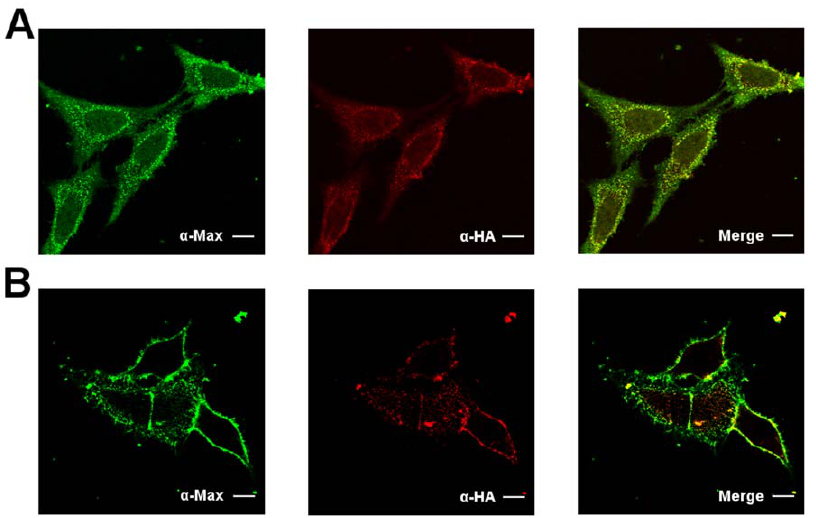
Figure 2. The b-HLH-LZ of Max directly transduces into HeLa cells. Confocal immunofluorescence photomicrographs of HeLa cells incubated for 20 minutes with Max*-HA at 37 u C A) and 4 u C B). Detection with a -Max, a -HA tag and the merge are displayed from left to right respectively. A) Note the punctuated (endosomes) and diffused labeling inside the cytoplasm and nucleus. B) At 4 u C, internalization is inhibited and the fluorescence is confined to the cell surface. Note the colocalization of the fluorescence of the a -Max and a -HA labeling. Scale bar=10 m m.